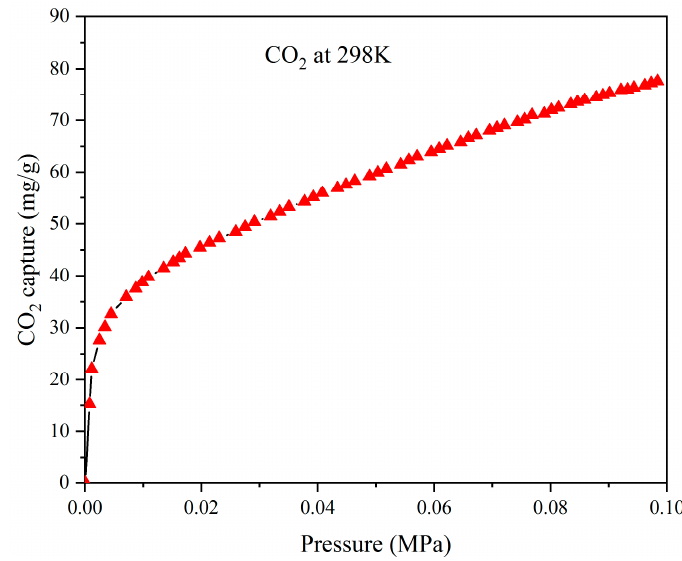
Figure 10. CO 2 adsorption isotherm of aerogel (AP–RD/GO–CT (20%)) at 298